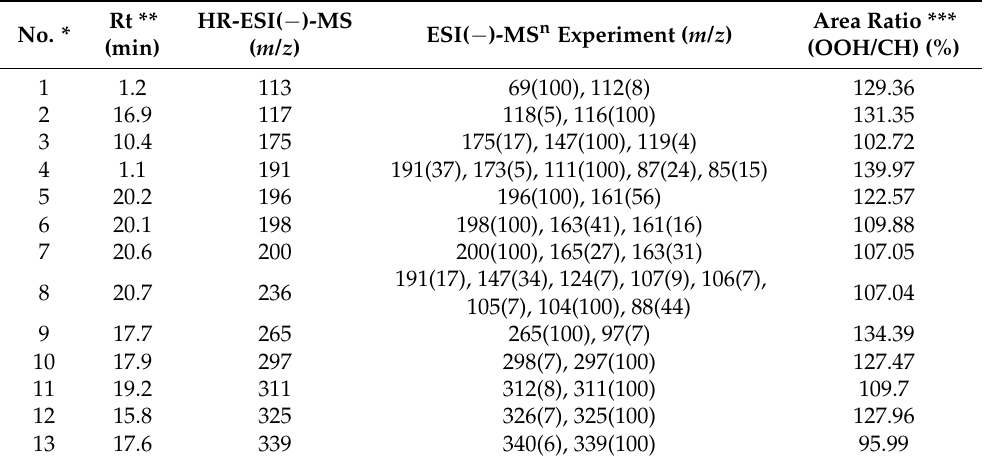
Table 4. A comparison of the major identified components present in pineapple core extracts from optimal ohmic heating and conventional